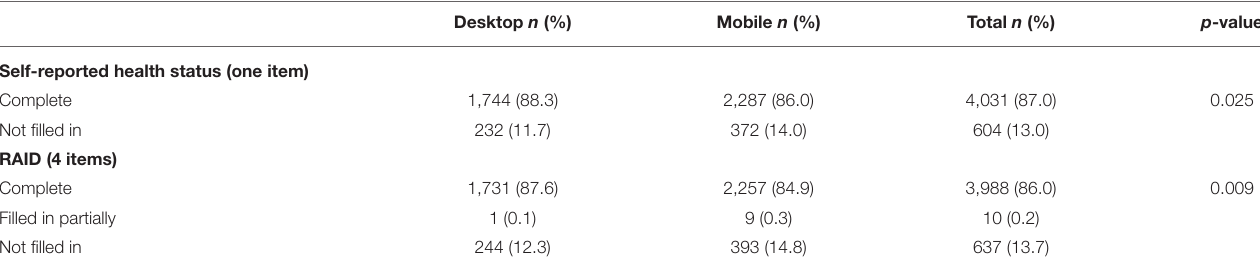
TABLE 3 | Self-reported health status and rheumatoid-arthritis-impact-of-disease questionnaire (RAID) as proxies for the quality/completeness of patient reported outcome instruments filled in with differing